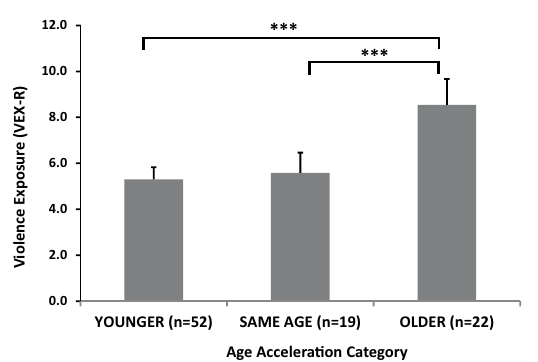
Figure 2. Frequency of directly experienced violence (VEX-R) across the accelerated age groups. The epigenetically oldest group, + 1 residual of the age acceleration, had almost twice as much violence exposure than the other groups. An ANOVA showed a significant effect of group on levels of experienced violence, F(2,92) = 10.59, p < 0.001, post-hoc tests *** p < 0.01. Abbreviations: VEX-R, Violence Exposure Scale for Children